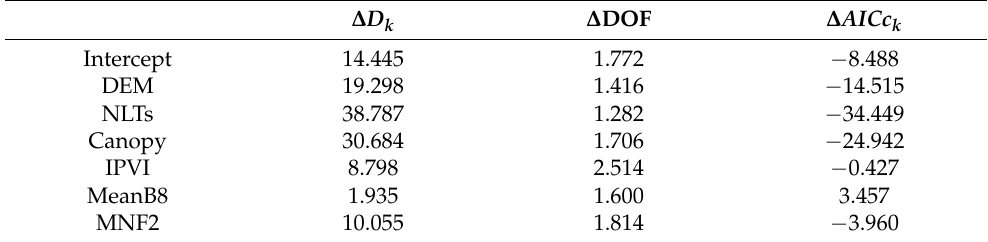
Table 4. Statistics for the geographical variability tests of the GWPR model for local